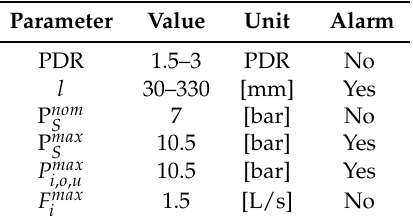
Table 5. System operating